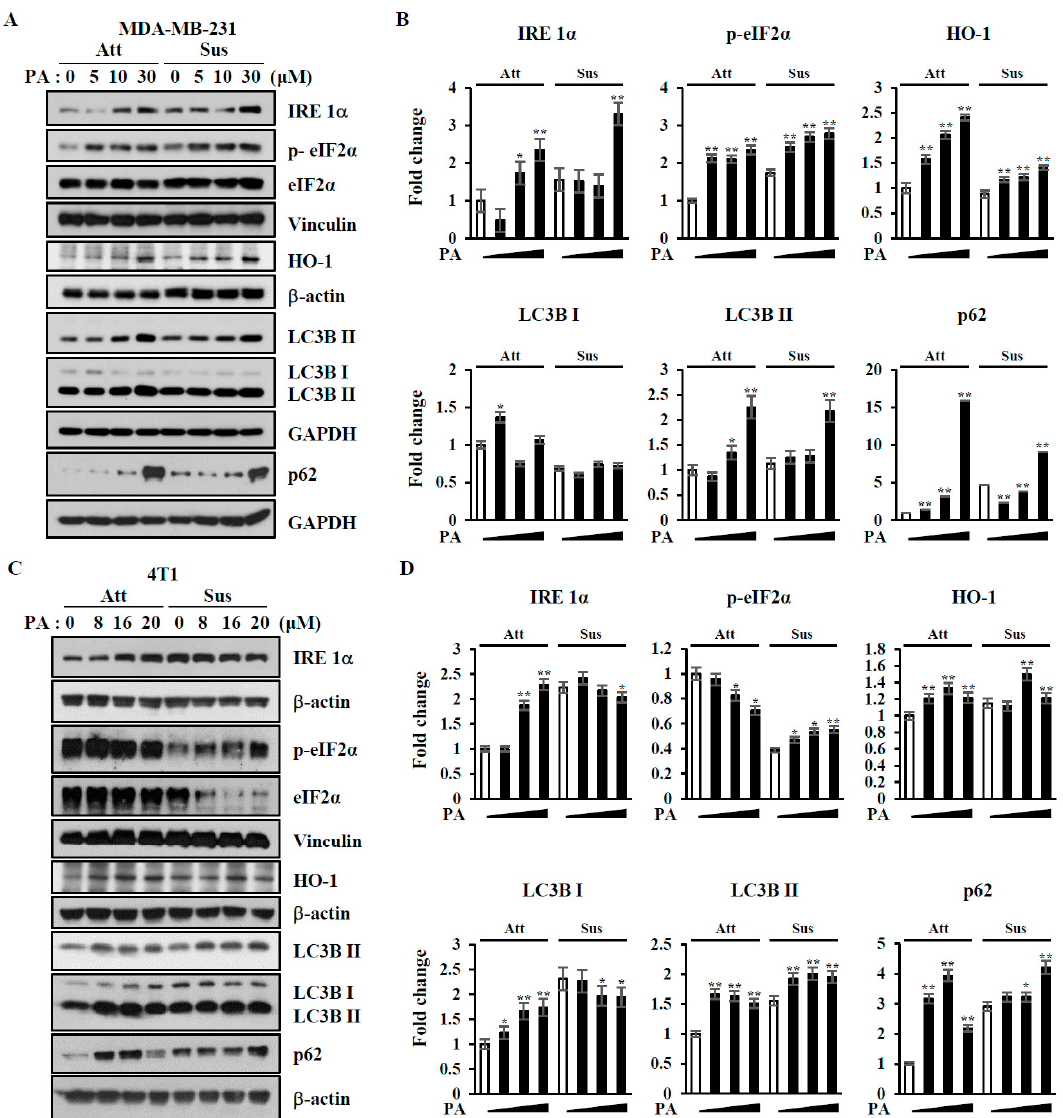
Figure 5. E ff ects of PA on the expression of markers of ER-stress and autophagy. ( A , C ) MDA-MB-231 cells ( A ) and 4T1 cells ( C ) were treated with the indicated concentrations (0–30 µM) of PA for 24 h, and cell lysates were subjected to immunoblotting analysis using the indicated antibodies. ( B , D ) The levels of proteins were quantified by densitometry and normalized to reference proteins (actin or vinculin). Error bars represent standard deviations of the mean of three measurements (* p < 0.05, ** p < 0.01). Similar results were observed in three independent experiments.